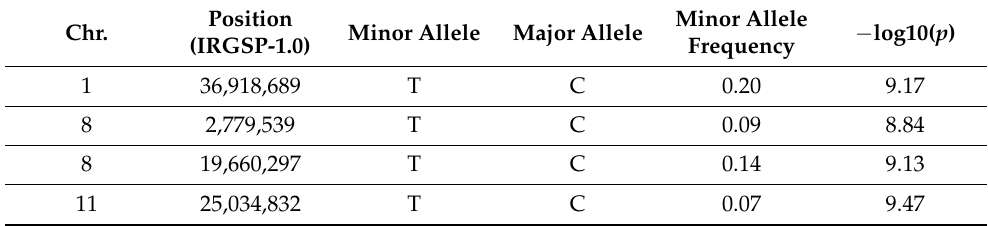
Table 3. Top highest significant association signals for sheath blast resistance using EMMAX.